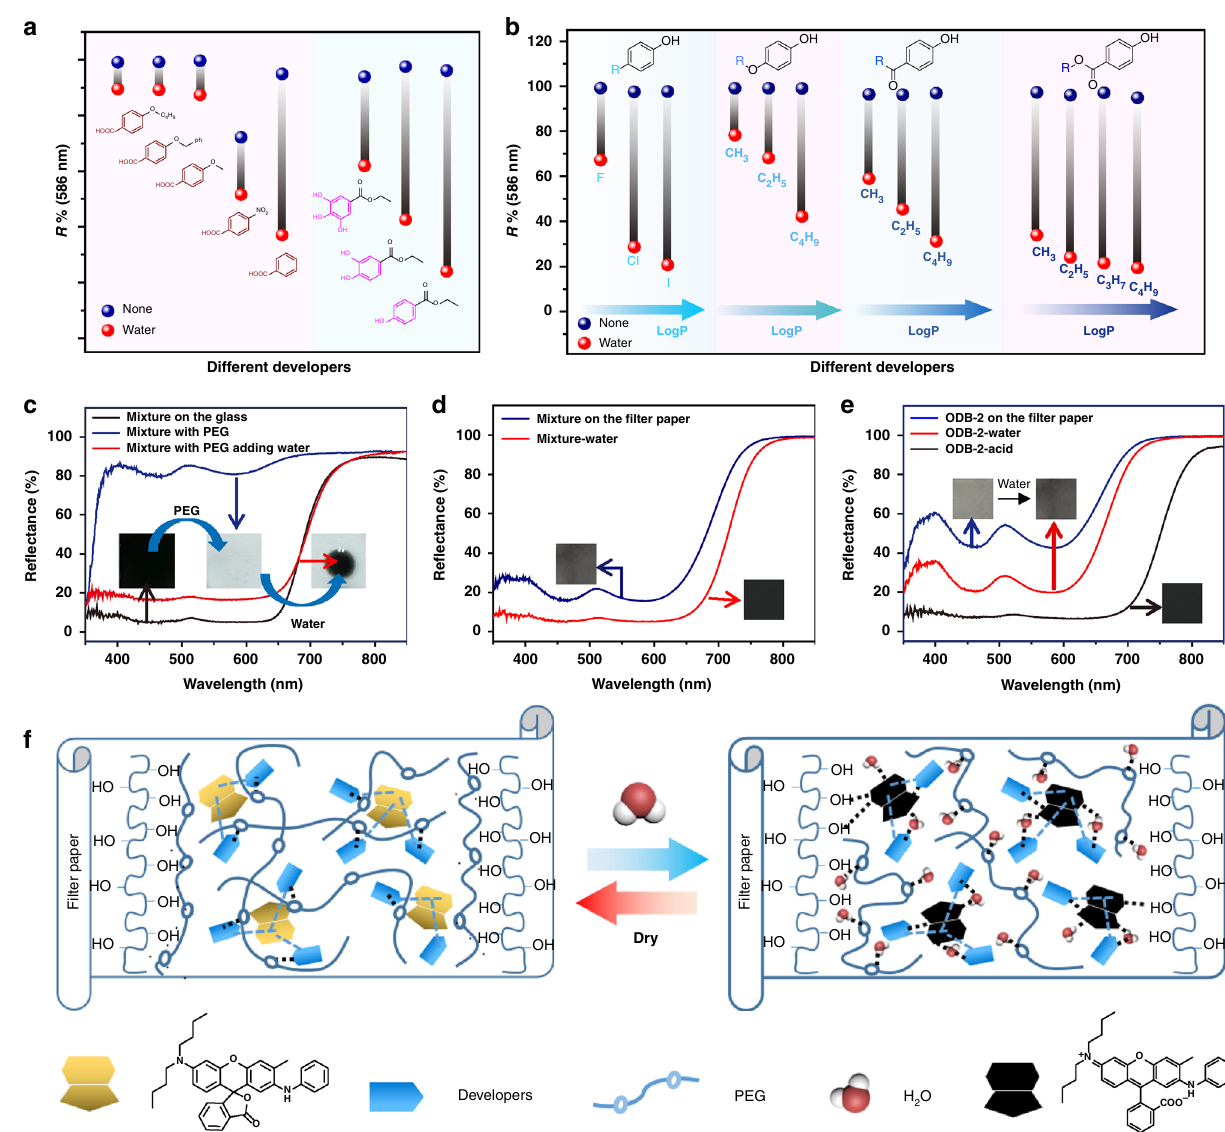
Fig. 3 Function of each component in WJRP and the hydrochromic mechanism of WJRP. Variation of re fl ectance ( R %) at 586nm of WJRP integrated with ODB-2/developers ( n / n 1/4) including a carboxylic acid derivatives and polyhydroxyls phenol derivatives and b developers with different logP before (blue dots) and after addition of water (red dots). c UV – vis re fl ection spectra of the mixture of ODB-2 and B4H on the glass before and after introduction of PEG and the mixture with PEG after adding water. d UV – vis re fl ection spectra of the mixture of ODB-2 and B4H on fi lter paper before and after addition of water. e UV – vis re fl ection spectra of ODB-2 alone dispersed on fi lter paper before and after addition of water as well as adding acid. f Schematic representation of WJRP based on the binary system writing with water and the erasing process (blue dashed line: supramolecular interaction, black dashed line: